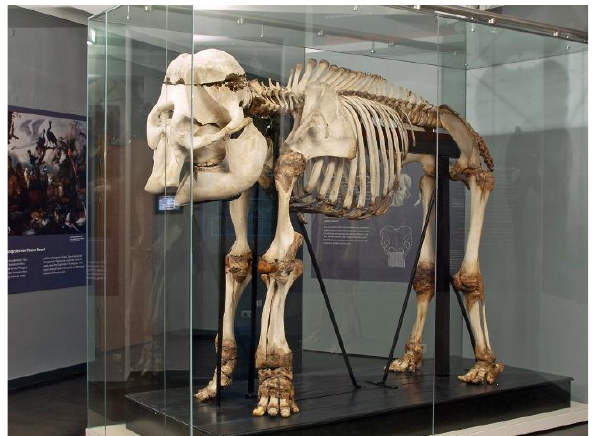
Figure 1 . Skeleton of the Goethe Elephant in Kassel (© Peter Mansfeld,